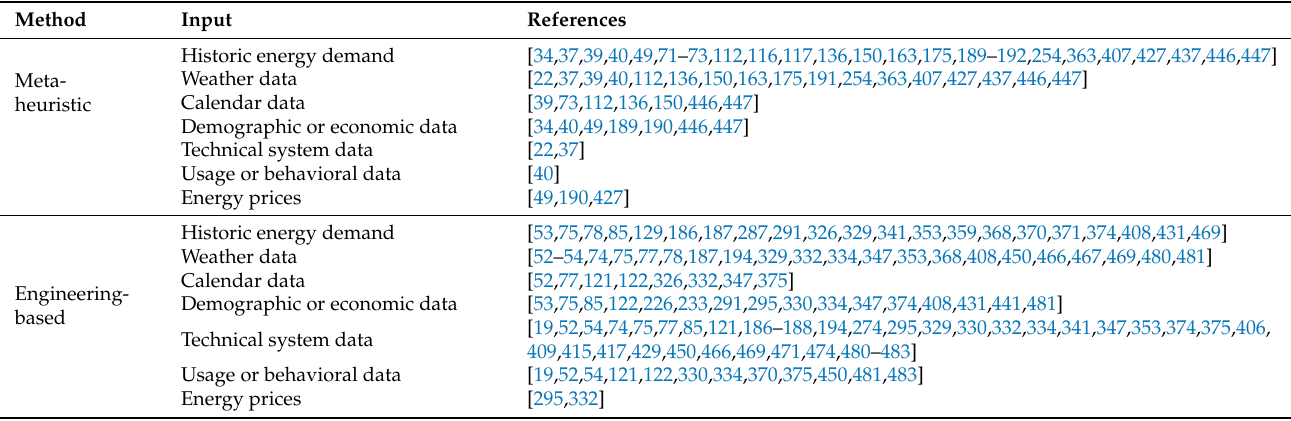
Table A7. Techniques and input data used per article (4/4). Continuation of Table